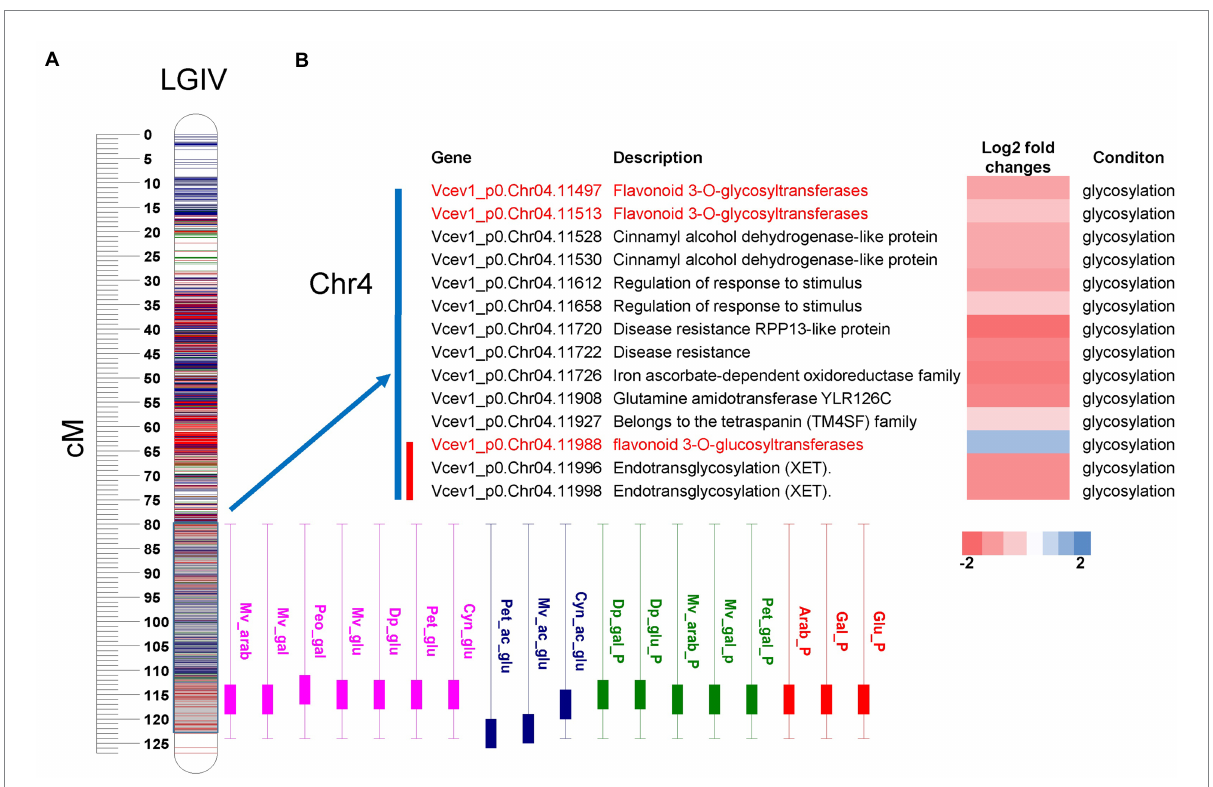
FIGURE 6 QTL mapping and differentially expressed genes from RNA-seq analysis. (A) Representation of the glycosylation related QTLs cluster mapped on chromosome 4. Boxplot represents the QTL position for individual anthocyanin concentrations (rose), acylated anthocyanins (blue), % contribution of individual anthocyanins (green) and % contribution of each sugar moiety to totalANC (red). The boxplot represents the 95% permutation support interval (the interval where the QTL peak exceeds the LOD threshold established using 1,000 permutations and α = 0.05). The solid box of the boxplot represents two-LOD support interval. (B) List of DEGs located within the genomic region spanning the 95% permutation support interval (blue bar) and two-LOD support interval (red bar). Potential candidate genes are highlighted in red. Log2fold change represents the gene expression levels from down-regulated (red) to up-regulated (blue). Condition represents the following pairwise comparisons performed for gene expression analysis: Glycosylation = high-glycosylated vs. low glycosylated samples. For each trait, the two-LOD and 95% support interval presented here represent the overlap of the QTL regions detected across 3